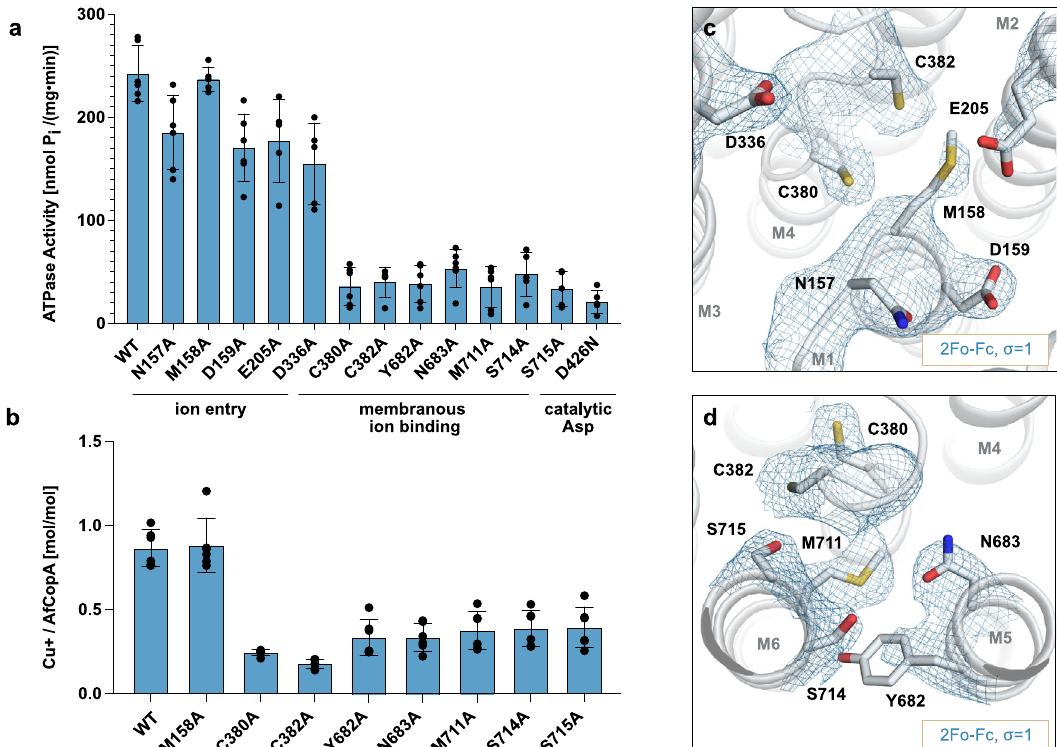
Fig. 3 | Functional characterization. a Cu + -stimulated ATPase activity of selected mutant forms as determined by a colorimetric in vitro ATPase assay based on protein reconstituted in liposomes. WT wild type AfCopA Δ N Δ C. Data were col- lected on material from two independent puri fi cations with n =5 (M158A, E205A, D336A,C382A,S714A,S715A,D426N)or n =6(othermutants),andarepresentedas mean ±SD. b Cu + bindingstoichiometriesdetermined byICP-MSmeasurementsof